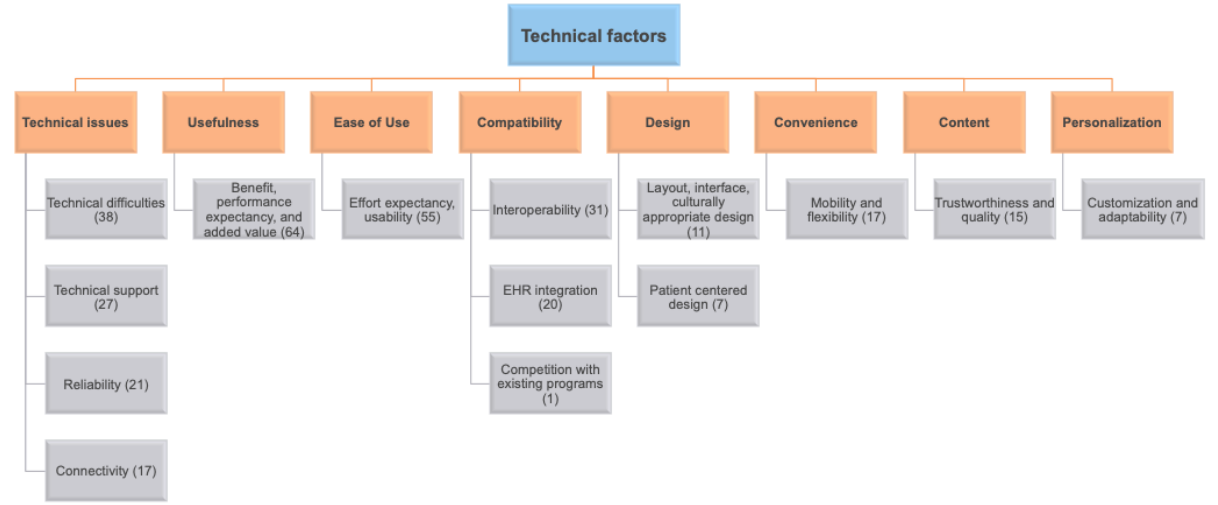
Figure 3. Overview of technological factors and their occurrence. EHR: electronic health